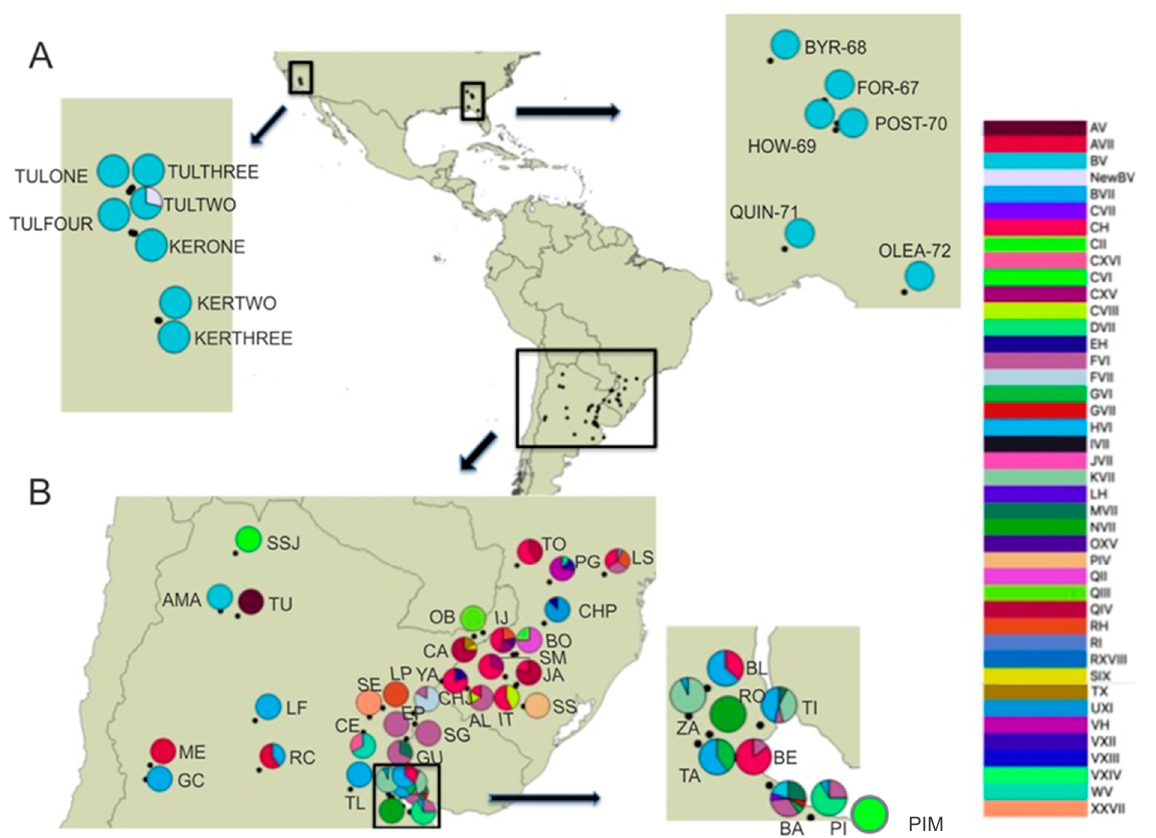
Figure 1. Geospatial distribution of combined genotypes of Naupactus cervinus for the Continental US ( A ) and the native range ( B ). Legend to the right lists all multilocus genotypes; pies indicate the relative presence of each multilocus genotype in each locality. Acronyms used for multilocus genotypes follow the nomenclature used by [19]. Localities are labeled according to codes in Table 1.